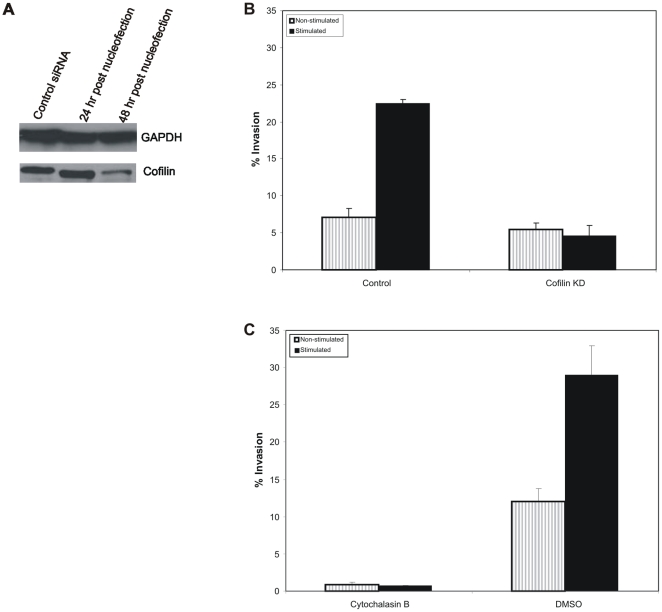
Silencing of Cofilin prevents mechanically stimulated invasion.
A) Western blot of cofilin from lysates of HT1080 cells treated with off-target control siRNA (lane 1, from left), and cells cultured for 24 and 48 hours after nucleofection with cofilin siRNA (lanes 2 and 3 respectively). Cofilin expression is reduced 48 hours post-nucleofection. GAPDH was used as loading control. B) HT1080 cells nucleofected with control siRNA or Cofilin siRNA and cultured for 48 hours were seeded onto collagen/fibronectin matrices containing paramagnetic beads. The cells were cultured with or without stimulation for 48 hours and the percent of invading cells was calculated. Invasion assays using control siRNA treated cells were repeated twice (15 fields were counted per trial). Stimulated cells had 3-fold higher invasion as compared to non-stimulated cells (P>0.05). The assay using cells when cofilin was silenced, was repeated four times (15 fields were counted per trial). The percent invasion between stimulated or non-stimulated cultures was insignificant (P>0.05). C) HT1080 cells were seeded onto collagen/fibronectin matrices containing paramagnetic beads. Cells treated with 2 µM Cytochalasin B or DMSO were cultured with or without stimulation for 48 hours and the percent of invading cells was calculated. Data represents three independent assays.